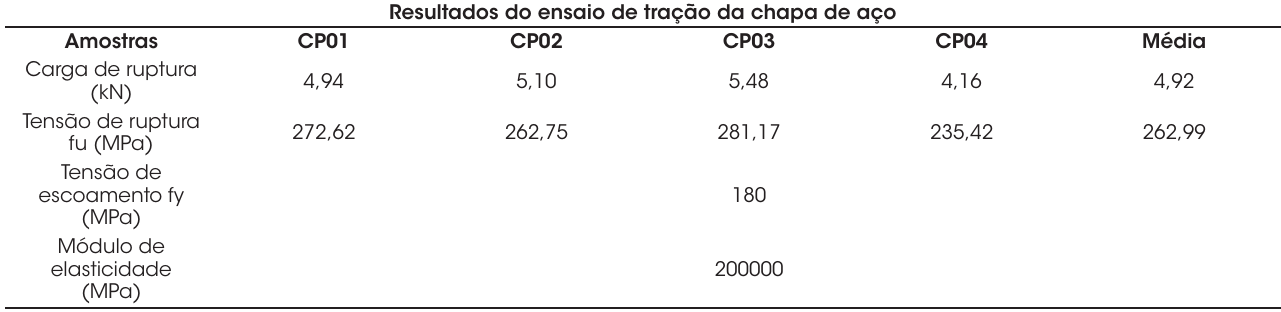
Figura 2: seção I (flexão), seção II (cisalhamento longitudinal) e seção III (cisalhamento